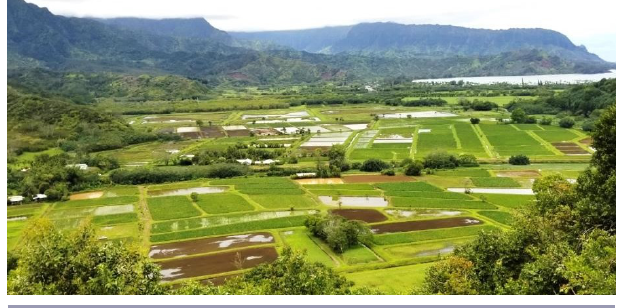
Fig. 3. A 2019 photograph of the heterogeneous landscape created by a wetland agroecosystem in the ahupua ʻ a of Hanalei on Kaua ʻ i Island. Photo credit: Kawika B.